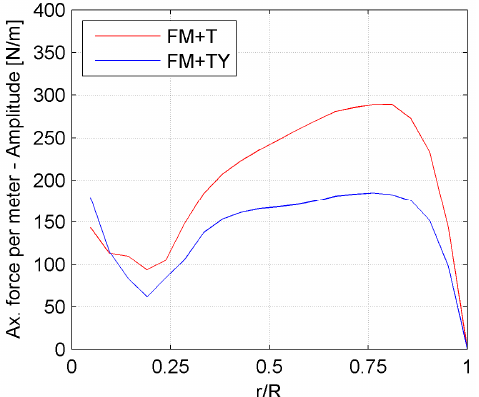
Figure 23. Amplitude of the axial force oscillation as a function of the span: FM + T vs. FM + TY.